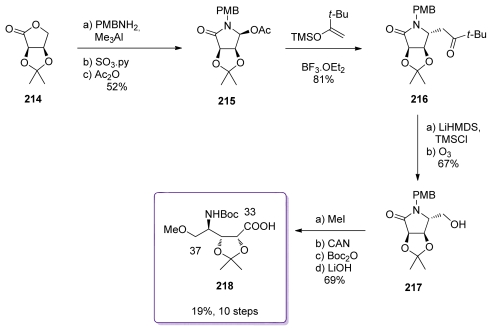
Preparation of 218.